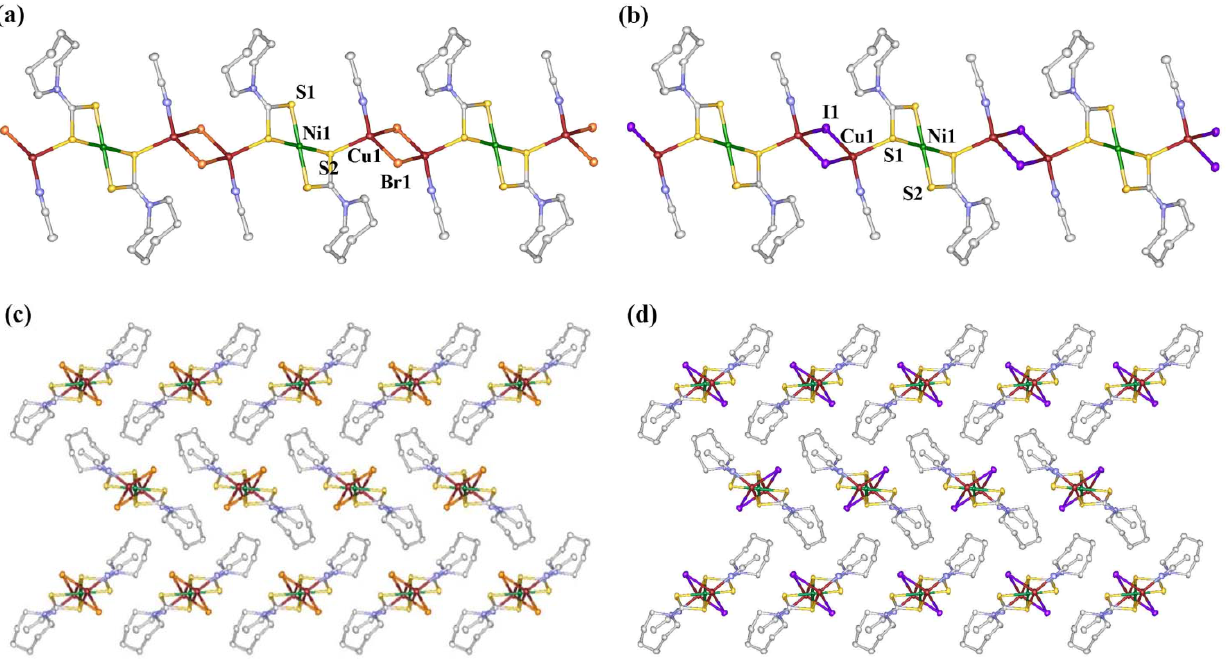
Figure 1. Infinite chain structures of 1D Cu(I)–Ni(II) heterometal coordination polymers of 1a ( a ) and 1b ( b ); packing diagrams of 1a ( c ) and 1b ( d ) viewed parallel to the a -axis: Cu, red-brown; Br, orange; I, purple; S, yellow; C, white; and N, blue. Hydrogen atoms are omitted for